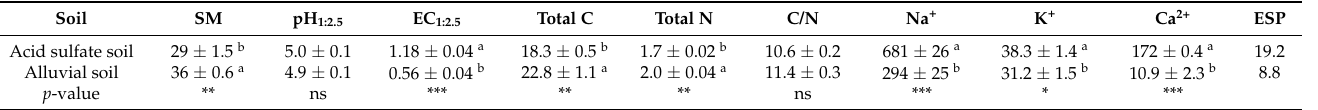
Value is mean and standard error ( n = 4). Different letters indicate significant differences among soils at * p < 0.05, ** p < 0.01, *** p < 0.001, ns-not significant. SM, soil moisture (%); EC, electric conductivity (mS cm − 1 ); Total C, total carbon (g kg − 1 ); Total N, total nitrogen (g kg − 1 ); Na + , soluble sodium (mg kg − 1 ); K + , soluble potassium (mg kg − 1 ); Ca 2+ , soluble calcium (mg kg − 1 ); ESP, exchangeable sodium percentage